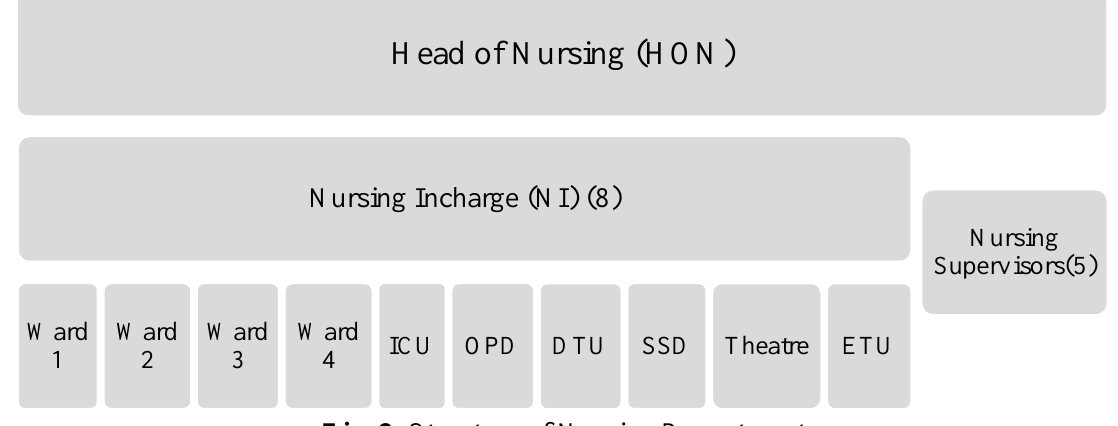
Fig. 2. Structure of Nursing